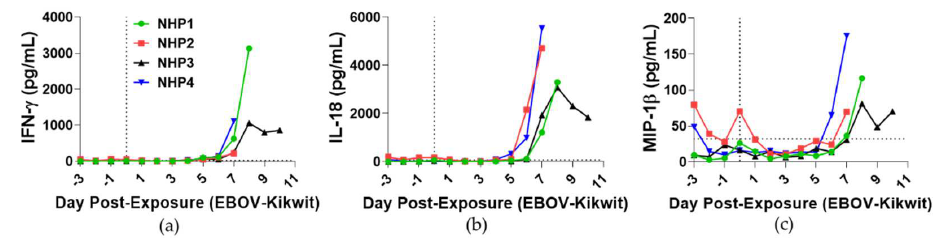
Figure 6. Analysis of immune responses in blood from aerosol EBOV-challenged rhesus macaques. Cytokine analyses of blood—( a ) IFNγ, ( b ) IL-18, and ( c ) MCP-1—were performed on samples collected 3 days prior to exposure and DPE 0–10. DPE 0 is marked by a black vertical dot line. Black horizontal dashed line is the average of all animals for DPE 0.